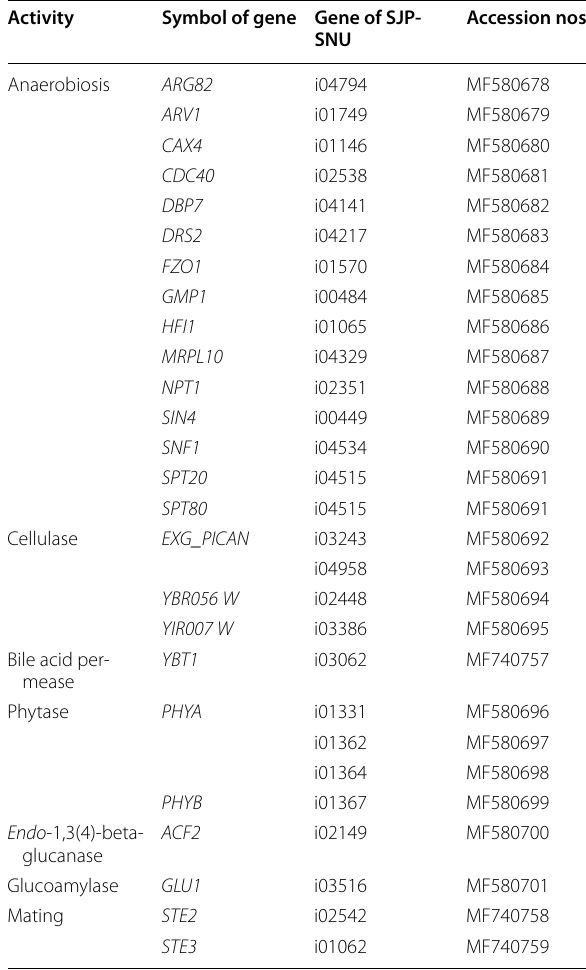
Table 3 Important genes for prediction of biological traits of SJP-SNU Activity Symbol of gene Gene of SJP‑